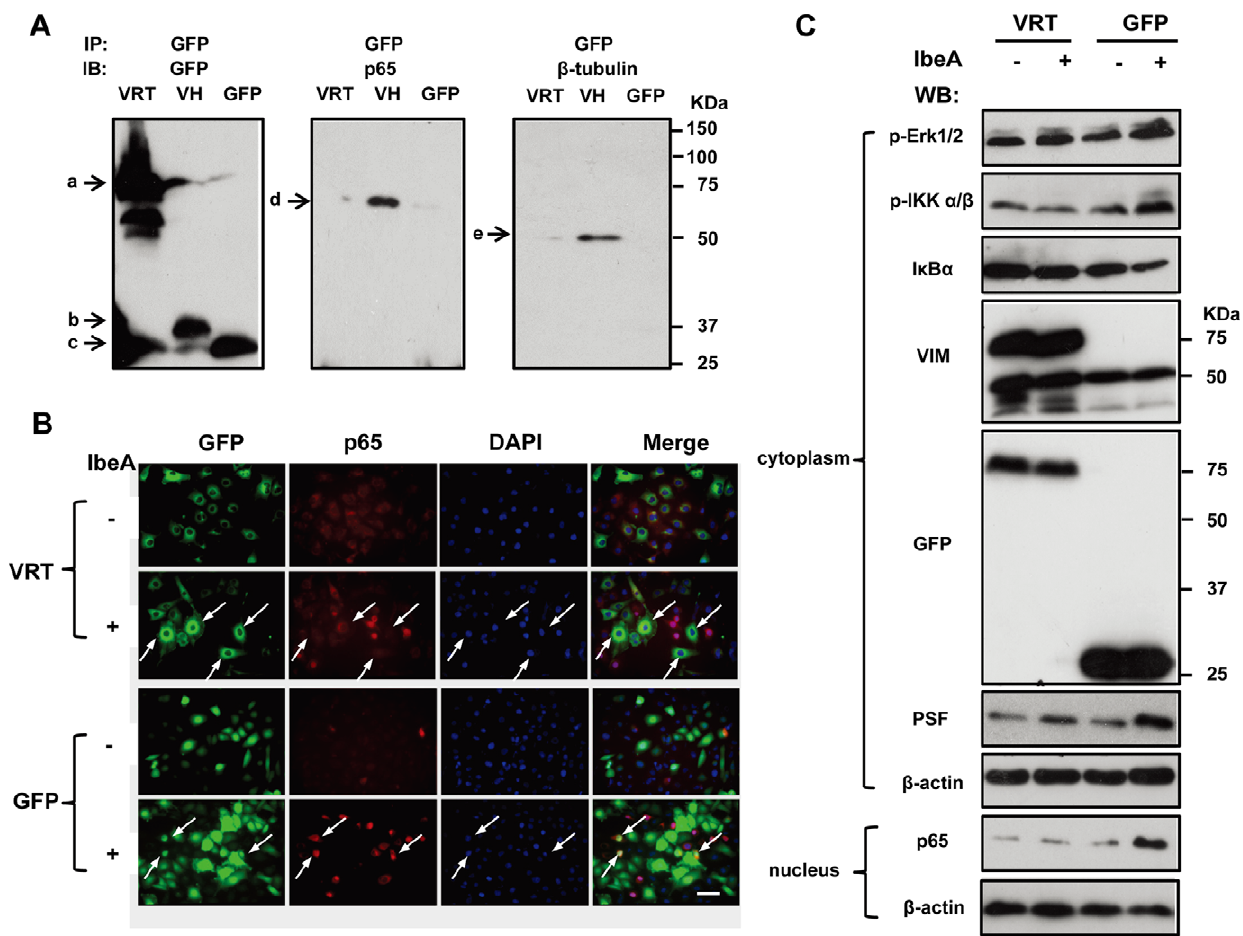
Figure 5. Effects of vimentin head domain deletion on IbeA-induced NF- k B activation and interaction with b -tubulin. ( A ) The cytoplasmic fractions of the GFP–VRT, GFP-VH and GFP transductants were extracted and immunoprecipitated (IP) using the mouse anti-GFP antibody as described in Materials and Methods. The GFP-IP complexes were subjected to Western blotting using the rabbit polyclonal antibodies against GFP, NF- k B (P65), and b -tubulin. Band a, GFP–VRT (72 kDa); band b, GFP-VH (37 kDa); band c, GFP (27 kDa); band d, NF- k B (P65), (65 kDa); and band e, b -tubulin, (50 kDa). ( B ) Immunofluorescence images of the GFP–VRT and GFP transductants incubated with or without the IbeA protein (0.1 m g/ml) for 2 h. The cells were double-stained with the rabbit antibody against NF- k B (p65) conjugated to rhodamine (red), and DAPI (blue). Arrows indicate cells with NF- k B (P65) translocation to the nucleus, which was increased in the GFP transductants and reduced in GFP-VRT- transduced HBMECs upon stimulation with IbeA. Scale bar, 50 m m. ( C ) Western blot of the transduced HBMECs treated with the IbeA protein (0.1 m g/ ml). ERK1/2 phosphorylation (p-Erk1/2), IKK a / b phosphorylation (p-IKK a / b ), I k B a degradation, vimentin (VIM), GFP and PSF re-localization were examined in cytoplasmic fractions after 30 min of IbeA stimulation. NF- k B (p65) translocation to the nucleus was examined in nuclear fractions